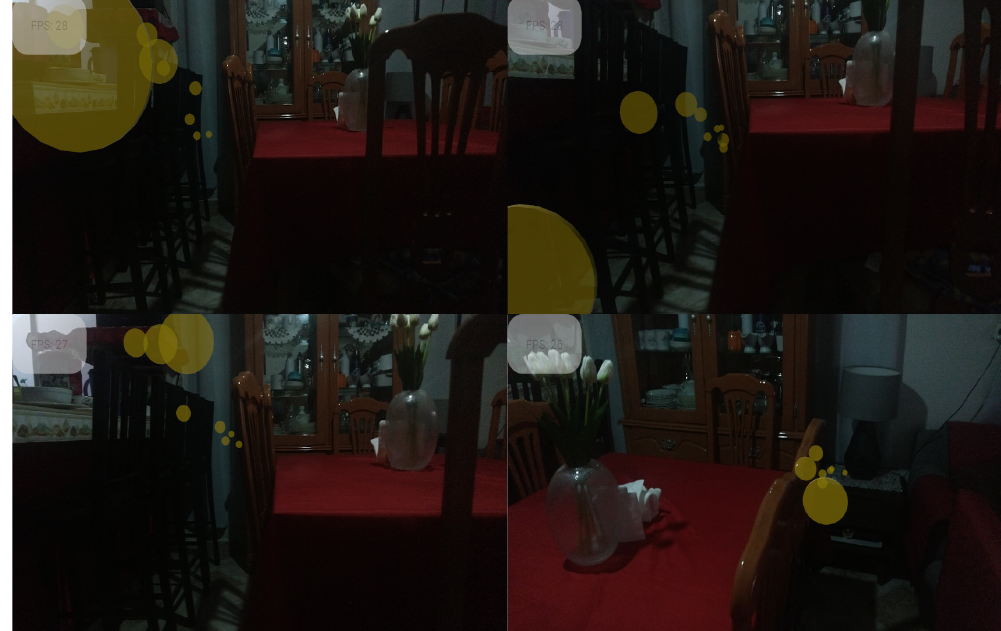
Figure 14. Virtual elements on the path to avoid obstacles in an unknown environment.